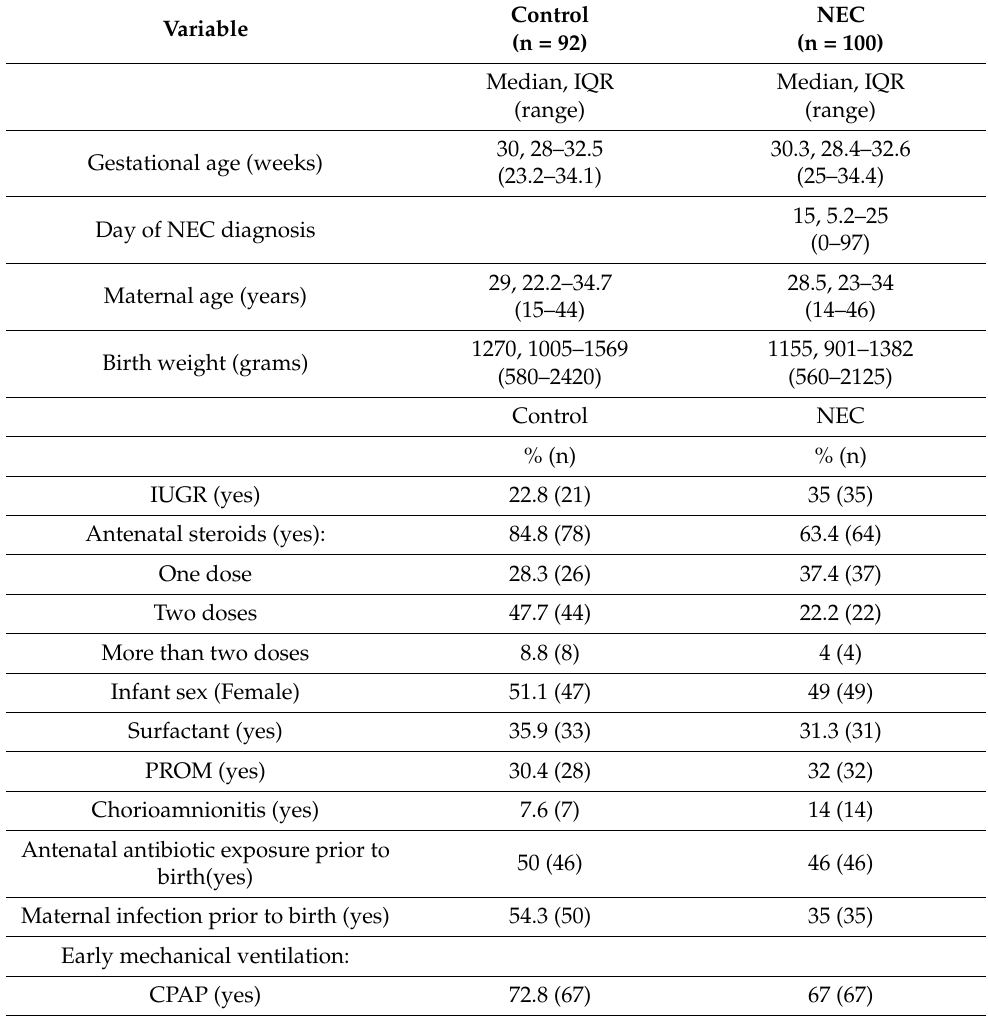
Table 1. Clinical and demographic characteristics of the